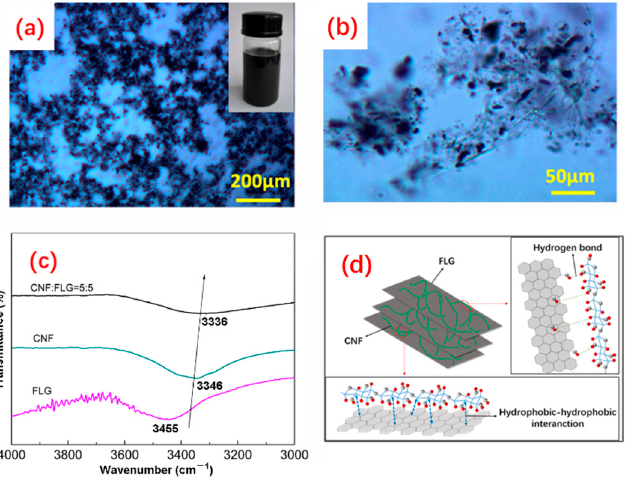
Figure 1. ( a , b ) Optical microscope images of CNFs-FLG. The inset is a digital photo of CNFs-FLG aqueous dispersion after 48 h resting; ( c ) FTIR spectra of FLG, CNFs and CNFs-FLG; ( d ) Schematic diagram of CNFs-FLG structure.